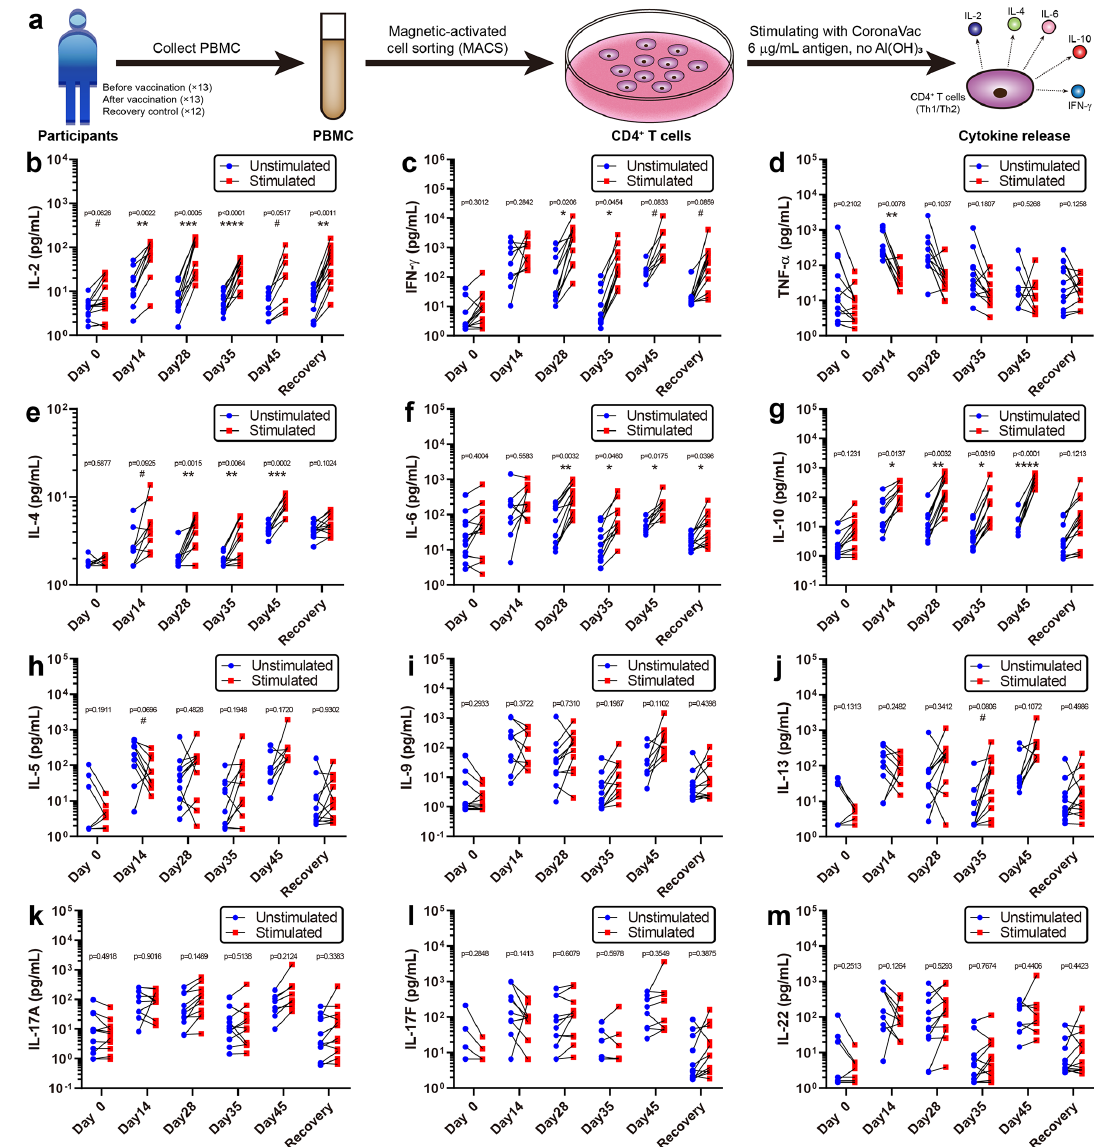
Figure 3. Cytokine release activity of CD4+ T cells. ( a ) Flowchart of the cytokine release activity assay. PBMCs were collected from all 25 participants, CD4+ T cells were isolated by MACS, and then one million CD4+ T cells per well were stimulated with CoronaVac, containing 6 µ g/mL antigen but no Al(OH) 3 adjuvant. Finally, the various cytokines released by CD4+ T cells were examined, and the mixed Th1/Th2 responses were observed. ( b – m ) Released cytokine concentrations were plotted ( n = 8–13). IL-2 and IFN- γ are Th1 cytokines that functioned during the early stages (Days 14, 28, and 35), while IL-4, IL-6, and IL-10 are Th2 cytokines that functioned at the later stages (Days 28, 35, and 45). Other cytokines did not generate a significant response. Multiple t tests were performed between stimulated and unstimulated groups with the p value and p summary reported. # p < 0.1; * p < 0.05; ** p < 0.01; *** p < 0.001; **** p <